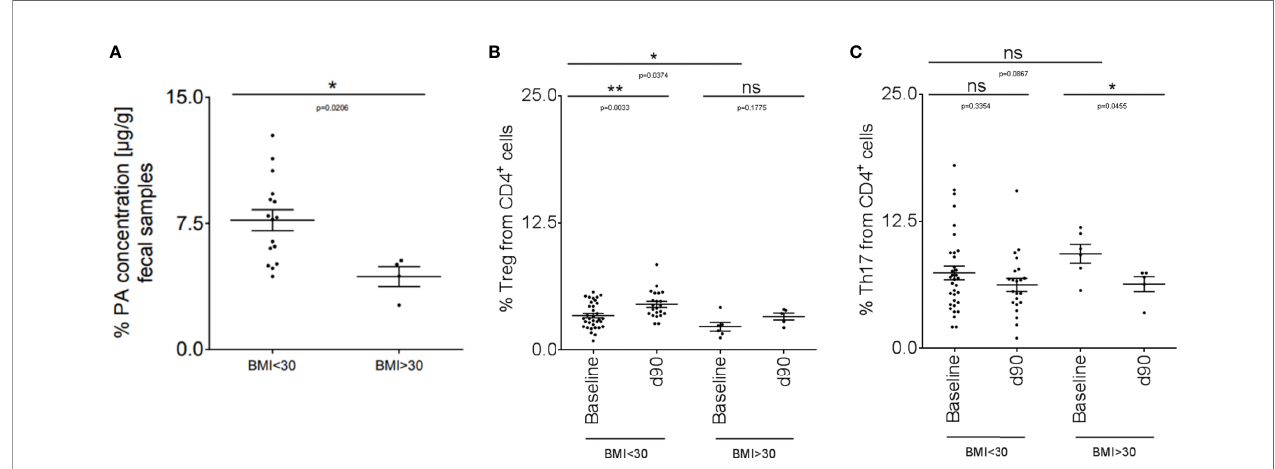
FIGURE 5 | PA supplementation in obese MS patients can restore the imbalanced Th17-Treg homeostasis. (A) PA concentrations were analyzed in fecal samples of non-obese (BMI <30; n=16) and obese (BMI >30; n=4) MS patients by LC-MS/MS. (B, C) Flow cytometry analysis of (B) Treg and (C) Th17 cells in the blood of non- obese (BMI <30) and obese (BMI >30) MS patients at baseline and after 90 days of PA intake (1000mg per day). BMI <30: baseline n=34, d90 n=22. BMI >30: baseline n=6, d90 n=5. p values are indicated in the fi gure and were determined by Mann-Whitney test. ns, not signi fi cant. *p<0.05, **p<0.01 using Mann-Whitney